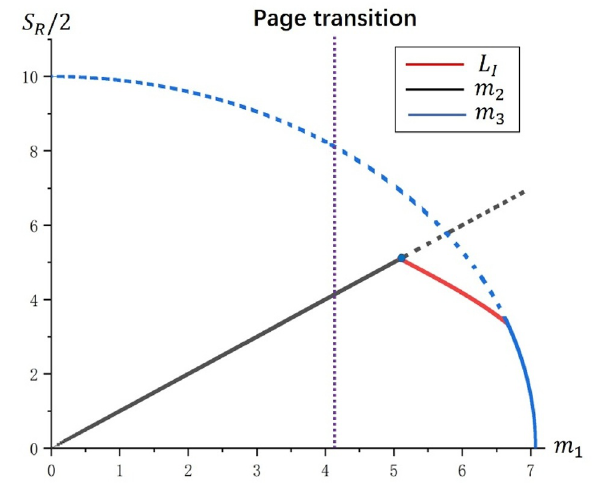
Figure 6 . The reflected entropy between R 2 and B is the minimum of these curves, i.e. the solid curve here. We can see that the transition point of reflected entropy between R 2 and B (marked by the blue dot) is later than the Page